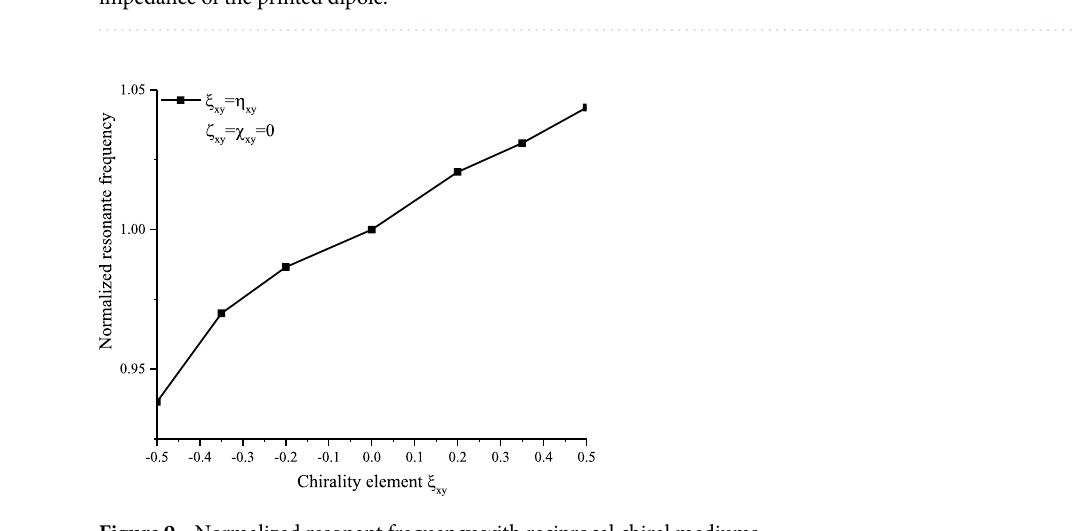
Figure 9. Normalized resonant frequency with reciprocal chiral mediums.